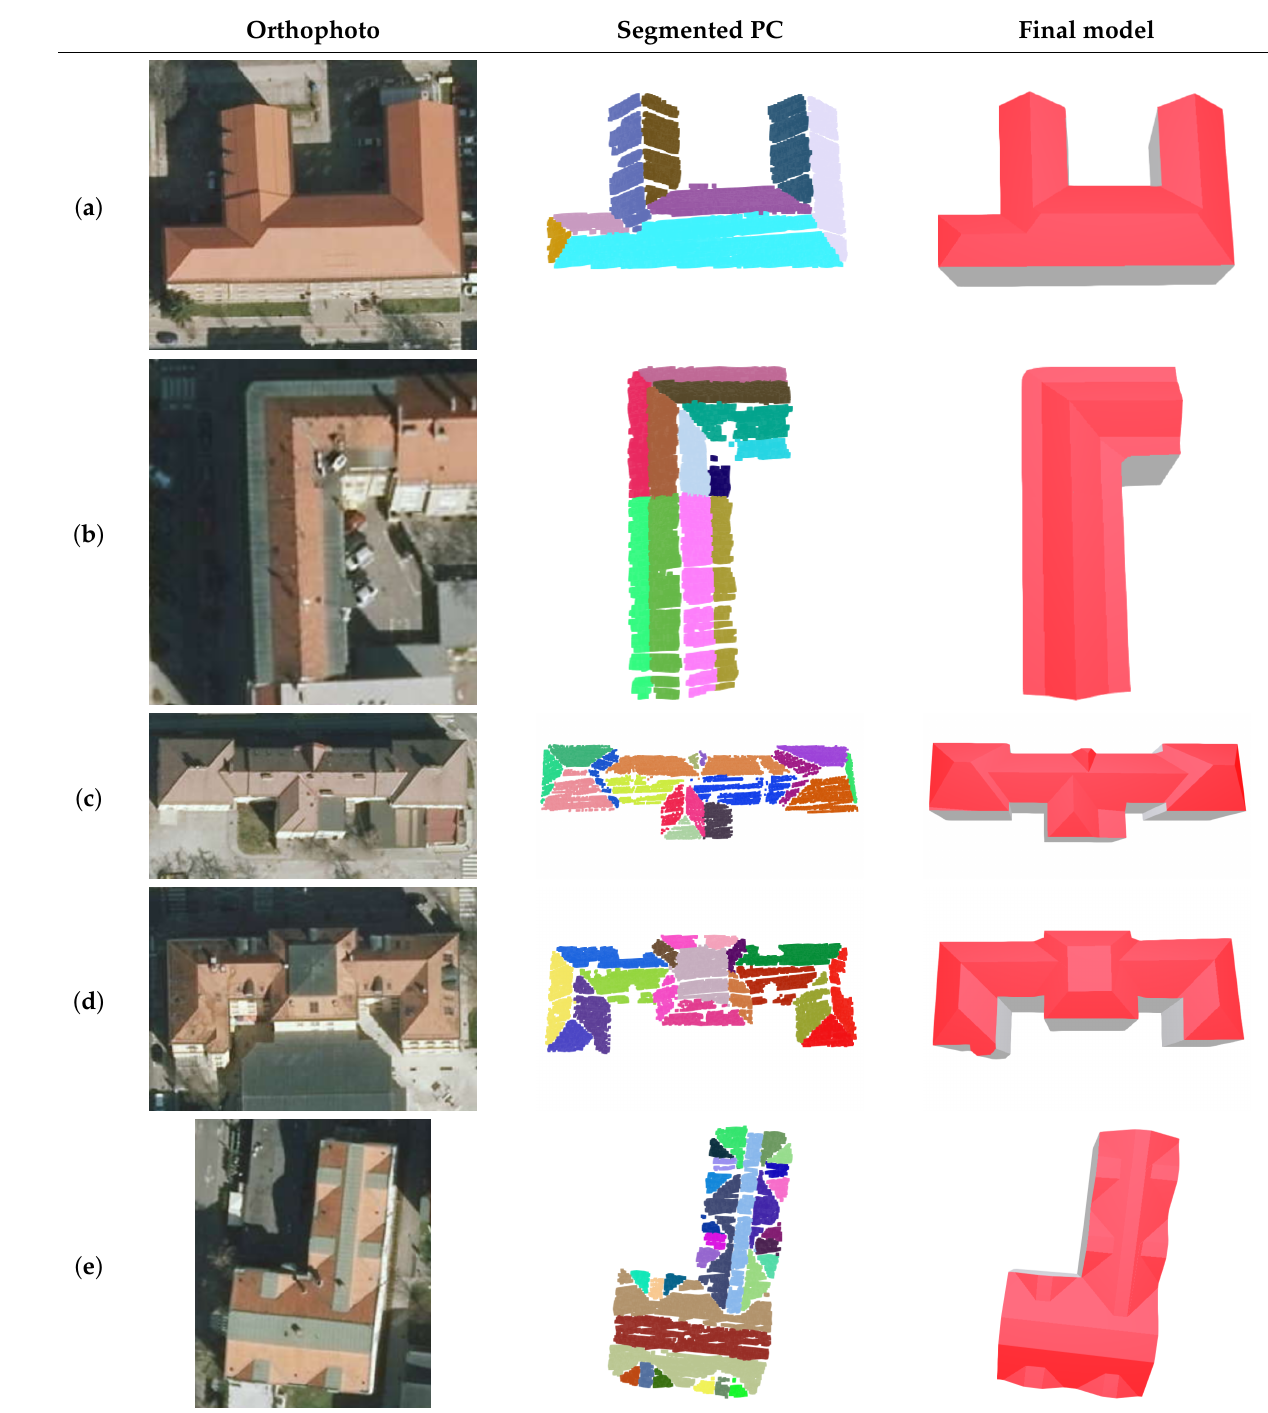
Figure 10. Illustrations of shaping several cases of buildings of various layouts with roofs without height jumps, where for the buildings ( left ) segments of points ( middle ) were obtained from the input point cloud for the reconstruction of buildings ( right